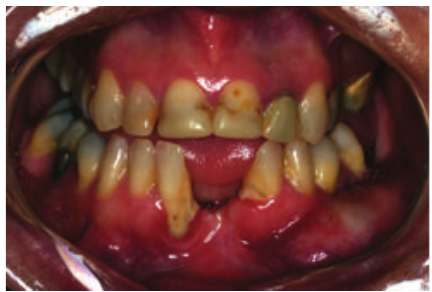
Figure 4: Transoperative view after tumor resection.